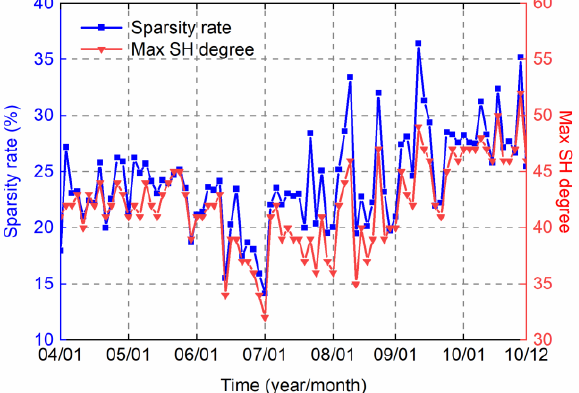
Figure 10. The sparsity rate (left axis) and maximum SH degree (right axis) of sparse DDK filtered solutions from January 2004 to December 2010. The sparsity rate is defined as the percentage of the number of nonzero elements to total number. Note that the degree 0 and 1 terms are not considered. The maximum SH degree is the highest degree of nonzero elements in each sparse DDK filtered solution. Table 5. The regional average annual amplitude of filtered mass anomaly solutions in six areas of different latitudes. The results are based on data from January 2004 to December 2010 and pre- sented in EWH (cm).